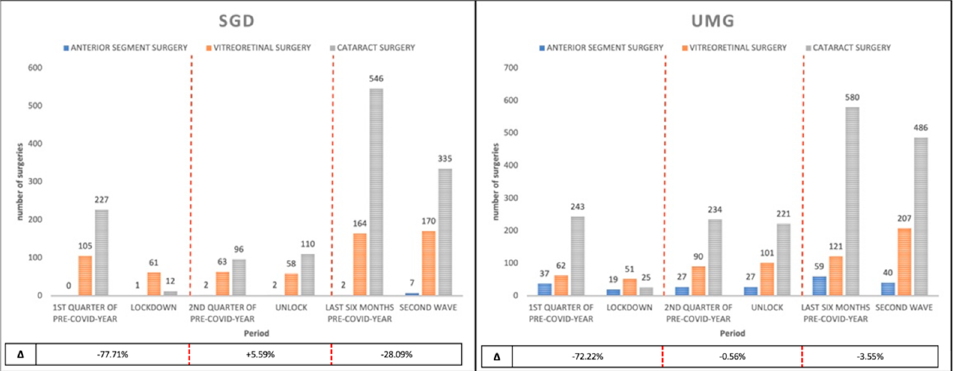
Figure 1. The change in the number of surgeries divided into 3 categories—anterior segment surgery (blue), vitreoretinal surgery (orange), and cataract surgery (grey)—performed at San Giovanni di Dio (SGD), University of Cagliari, and Mater Domini, University Magna Græcia of Catanzaro (UMG), in each study period. The box below presents the overall surgery percentage variation during the COVID-19 year.